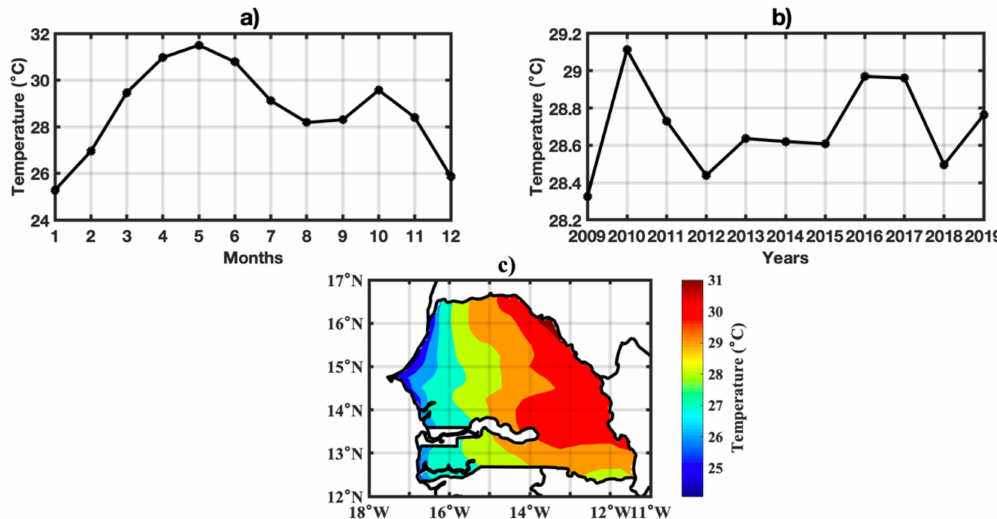
Figure 4. Spatio-temporal variability of temperature in Senegal from 2009–2019: spatial distribution